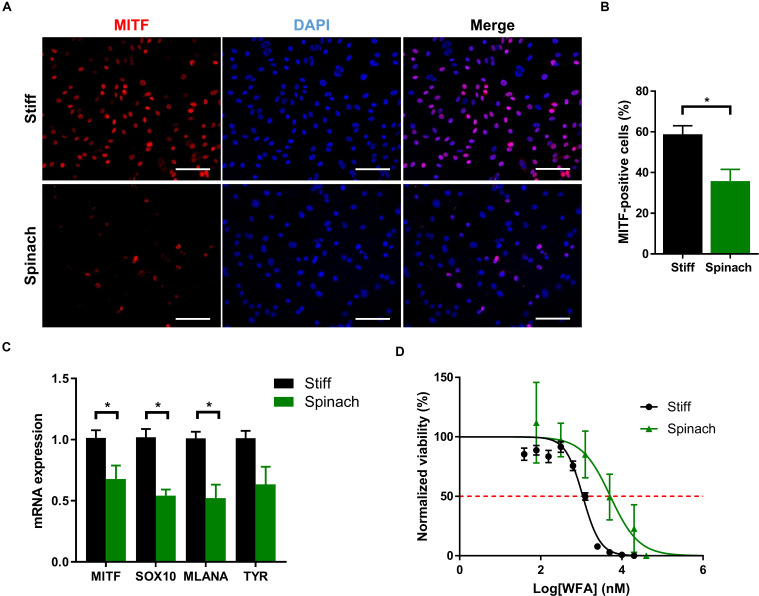
Cell culture on leaf scaffold decreased MITF expression and induced WFA resistance in melanoma SK-MEL-28 cells. (A) Immunofluorescence images of MITF and nuclei (DAPI) in SK-MEL-28 cells seeded on stiff substrate (coverslip) and spinach scaffold. Scale bars = 60 μm. (B) Histogram showing the percentage of MITF-positive cells and represented as mean ± SEM (n = 3, *p < 0.05; Student t-test). (C) Quantitative RT-PCR analysis in SK-MEL-28 cells to measure MITF and there MITF target genes (SOX10, MLANA, and TYR) mRNA levels. Cells were grown on TCPS or spinach scaffold for 3 days. Data were normalized to expression on TCPS and indicated as mean ± SEM (n = 3, *p < 0.05; Student t-test). (D) Effect of WFA treatment on SK-MEL-28 seeded on decellularized spinach leaves or TCPS assessed by modified MTT. Cells were exposed to either vehicle (DMSO) or a large range of concentrations (0.039 to 20 μM) of WFA for 72 h. Absorbance (570 nm) values were normalized from 100% in DMSO control and analyzed using a non-linear regression using dose response curve fitting [log (inhibition) vs normalized response (variable slope)]. Red dotted line intercepts dose-response curves at 50% viability representing IC50. The graph shows the mean ± SEM (n = 3 with four replicates each).